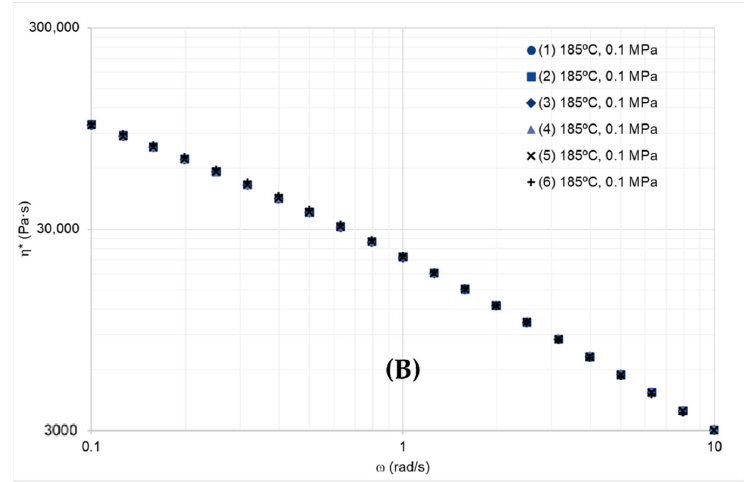
Figure 3. ( A ) Complex viscosity of several samples of Resin A as reported by the instrument (rheometer), ( B ) the same data recalculated using the actual radius in Equation (19).